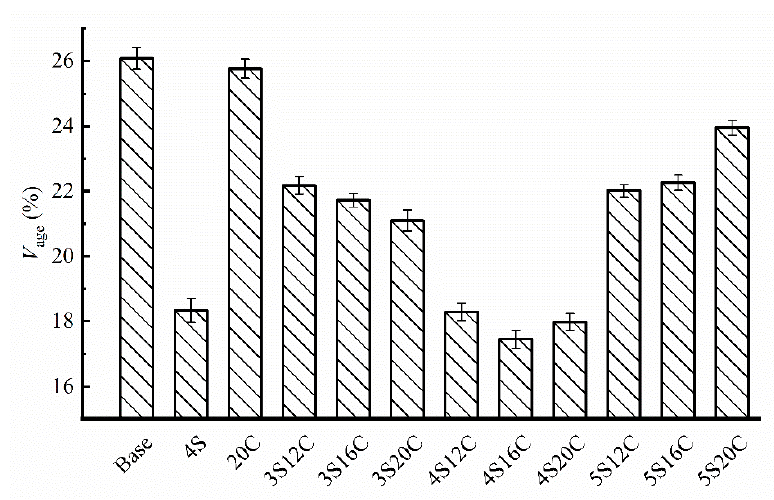
9 of 13 Figure 6. Evaluation indexes of basic properties: ( a ) the change of softening point ( C sp ), and ( b ) the change percent of penetration ( P age ). 4.2. Evaluation Indexes of Rheological Properties 4.2.1. Brookfield Viscosity Aging Index Figure 7 shows that minor anti-UV aging effect can be seen in rubber powder modified asphalt